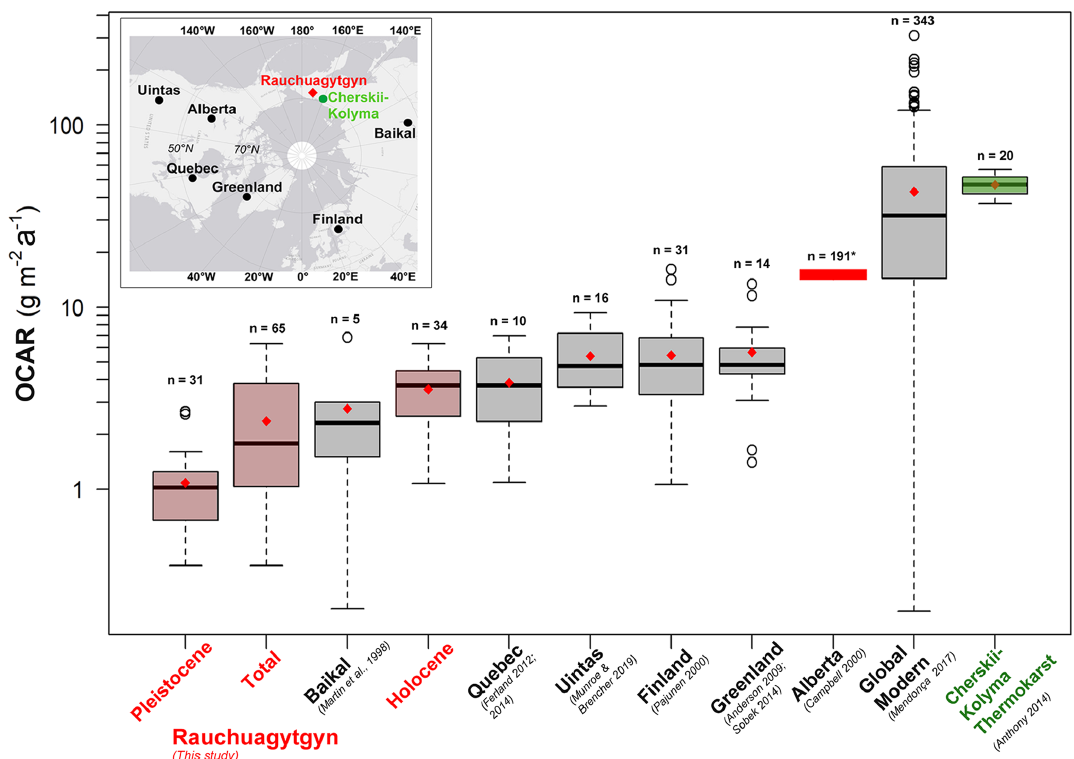
Figure 8. Comparison boxplot ( y axis is log to the base 10 scaled) of average organic carbon accumulation rates (OCARs) for Lake Rauchuagytgyn with carbon accumulation rates from other regions. Rauchuagytgyn OCARs include a total of 65 down-core points and plot close to boreal lake sites and to Lake Baikal (ESRI 2020). The global modern dataset of Mendoça et al. (2017) included OCARs from 343 globally distributed lake sites (see Text S1). Only the average OCAR across Alberta lakes was provided in Campbell et al. (2000), and hence the average is displayed as a red bar. Study references are quoted below the study